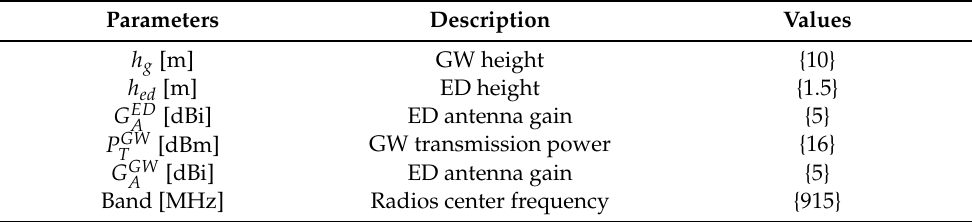
Table 1. Radio Mobile input